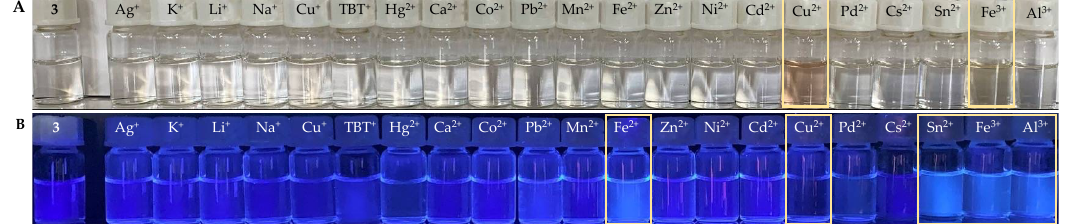
Figure 6. Solutions of compound 3 , in ACN/water (75:25) (1 × 10 −5 M), after adding 50 equivalents of cations, under natural light ( A ) and UV radiation at 365 nm ( B ).